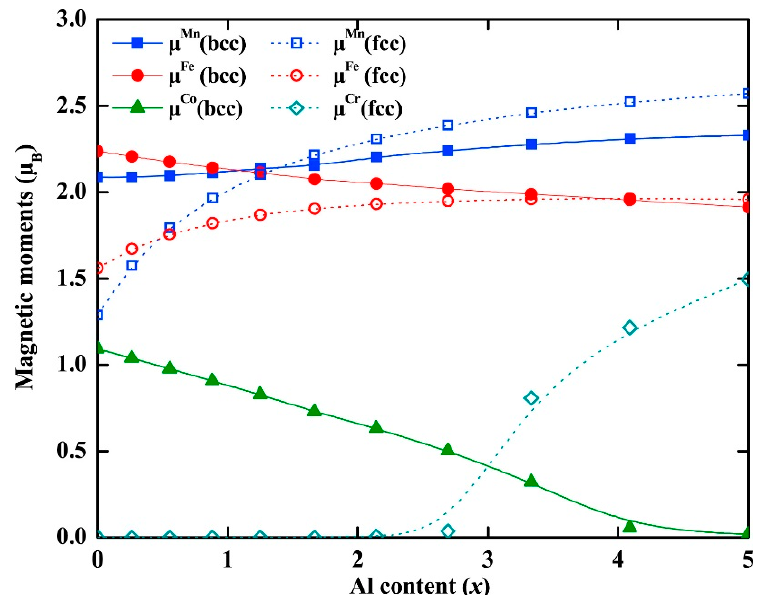
Figure 10. Theoretical local magnetic moments at 0 K for paramagnetic bcc (solid symbols) and fcc (hollowed symbols) Al x CrMnFeCoNi (0 ≤ x ≤ 5) MPE alloys as a function of Al content (this figure is from Reference [138]).